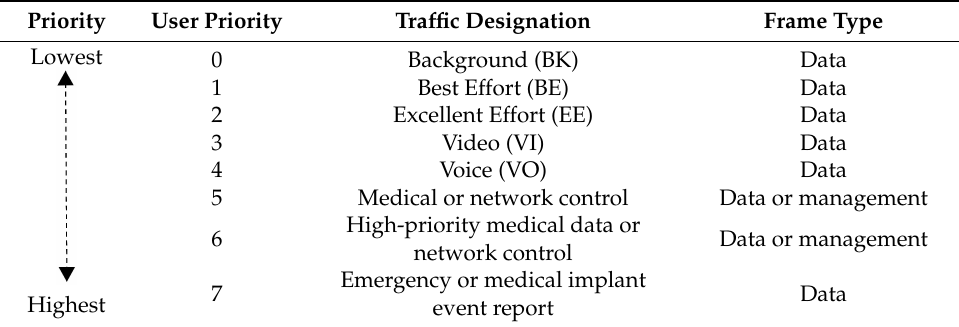
Table 1. Quality of Service (QoS) for IEEE802.15.6 [30].